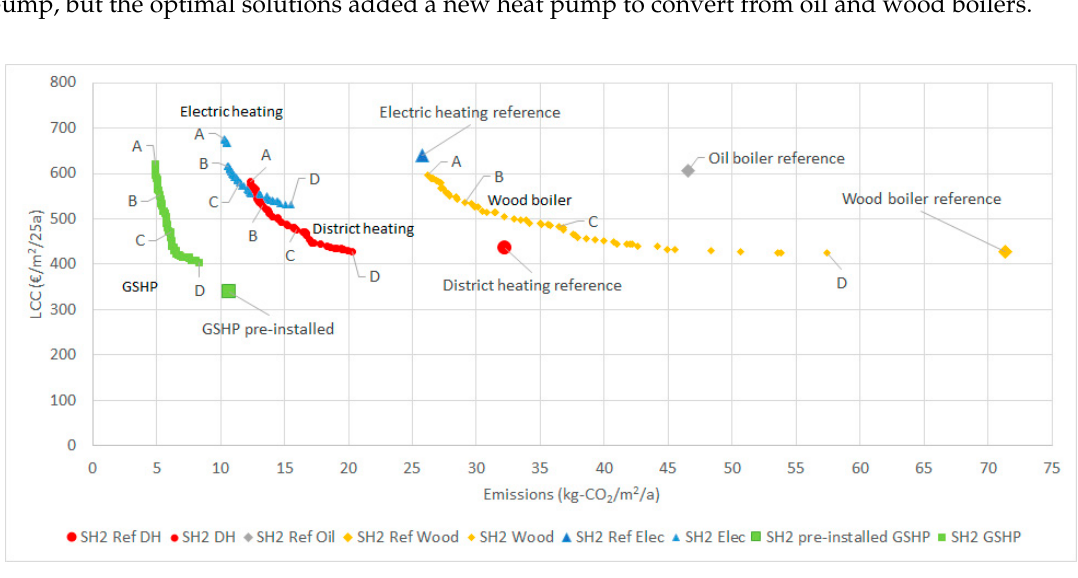
Figure 9. Reference cases and optimal results of retrofitting for the single-family house SH2 with different heating systems. di ff erent heating